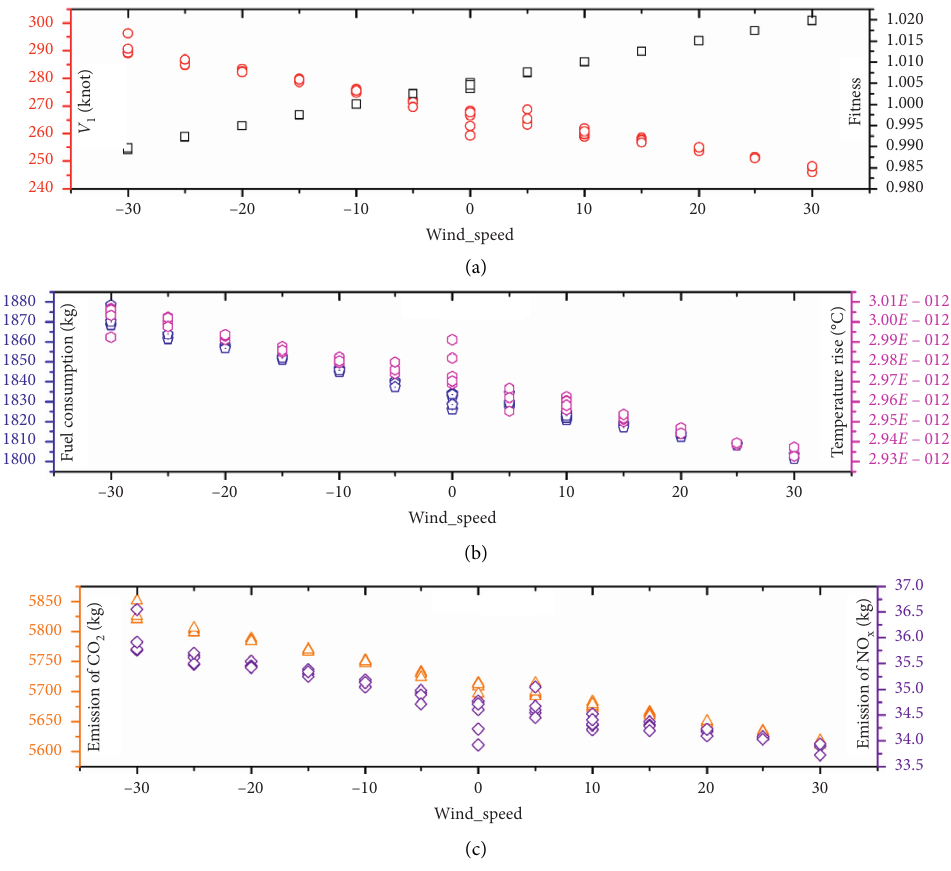
Figure 14: Effect of wind on optimization results.